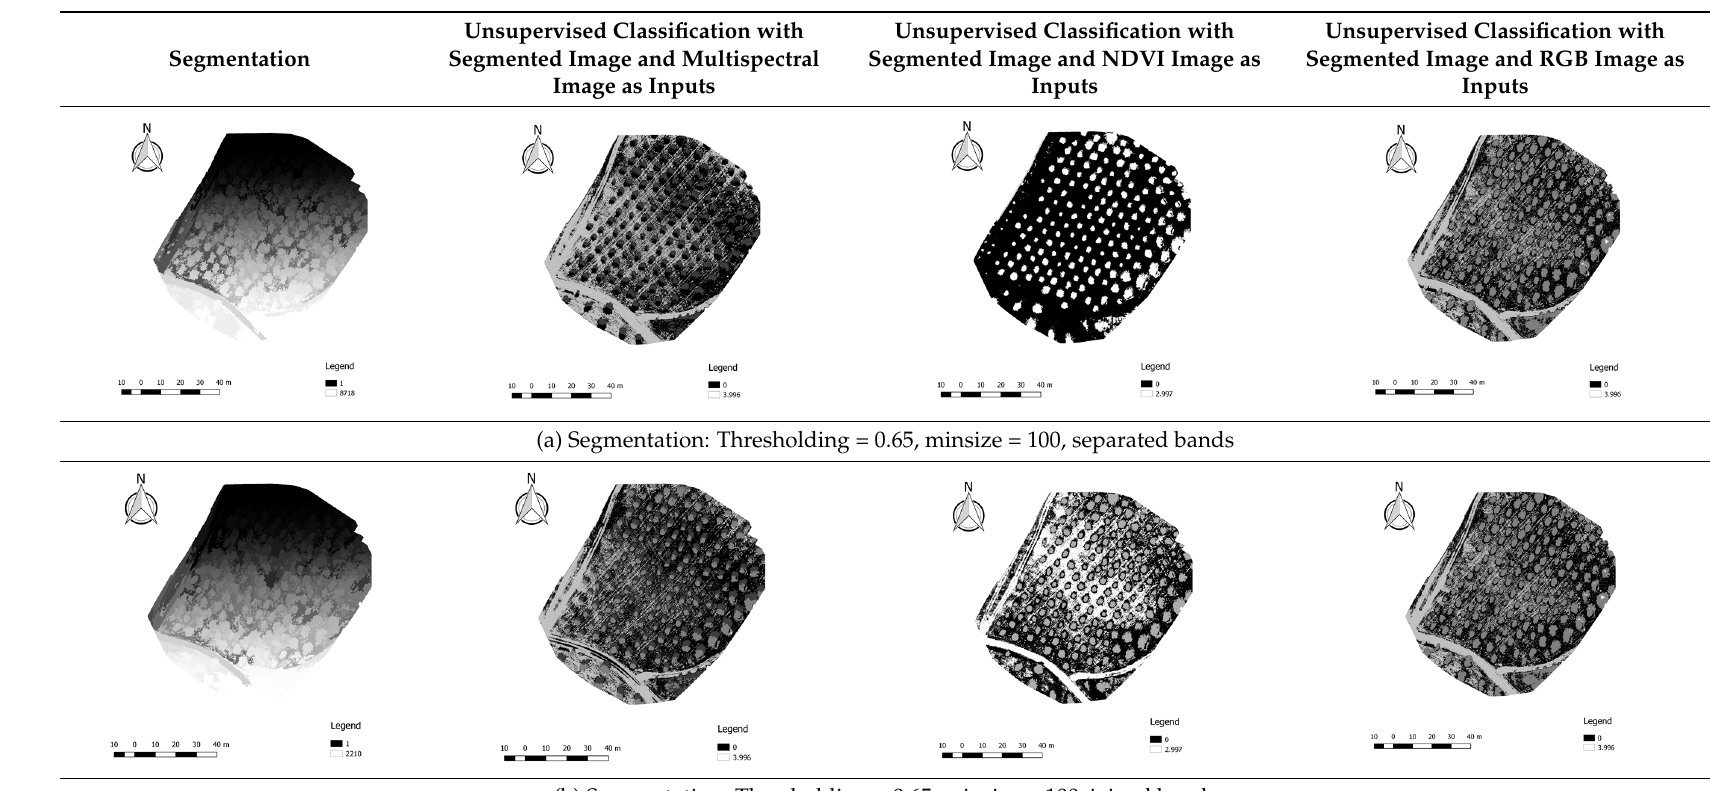
Table 1. Tests performed for segmentation and classification processes considering different values of thresholding and minsize for i.segment algorithm, in the segmentation process and considering different inputs (multispectral image, Red-Green-Blue (RGB) image, or Normalized Difference Vegetation Index (NDVI)) in the classification process.